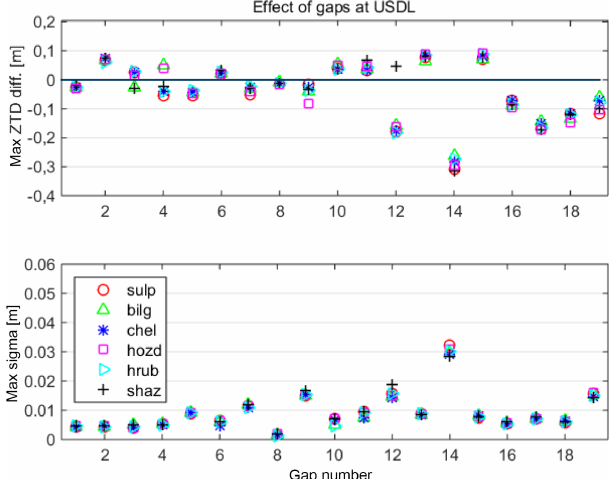
Figure 3. Maximum ZTD variation (positive or negative) at stations of the cluster based on SULP during data gap periods at station USDL (gap number 13 corresponds to day 226 on Fig. 2). Below is the corresponding formal